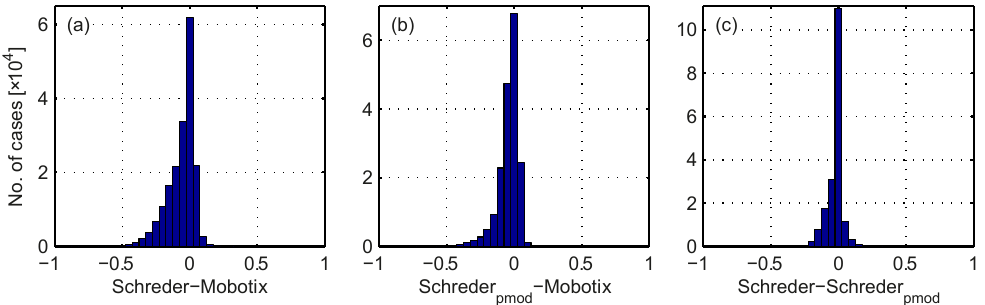
Figure 8. Residuals of the comparison of cloud fraction retrieved from the visible cameras and algorithms used in the study: (a) Schreder- Mobotix, (b) Schreder pmod -Mobotix and (c) Schreder–Schreder pmod .